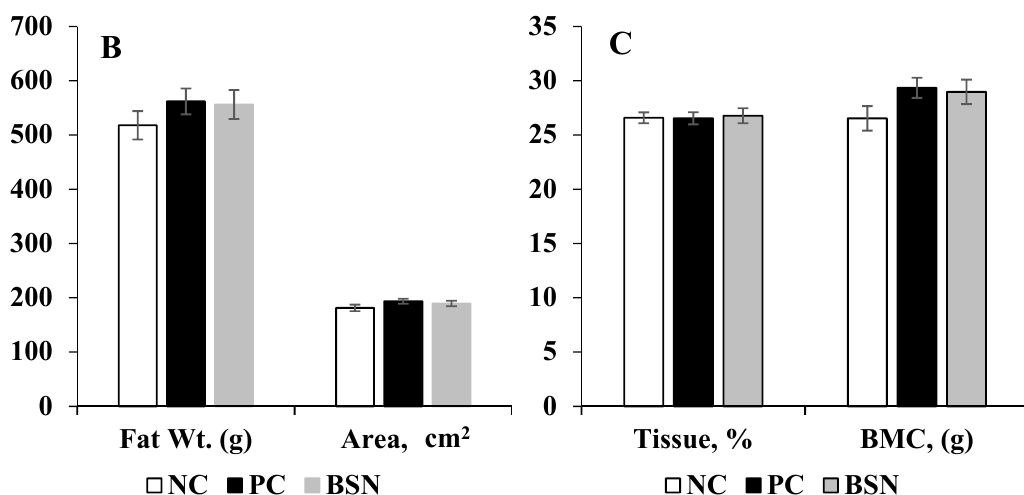
Figure 3. Effects of dietary non-drug feed additive (BSN) on body composition of broilers. ( A ) Carcass weight (g), tissue weight (g), and lean weight (g). ( B ) Fat weight (g) and body surface area (cm 2 ). ( C ) Tissue (%) and bone mineral content, BMC (g).